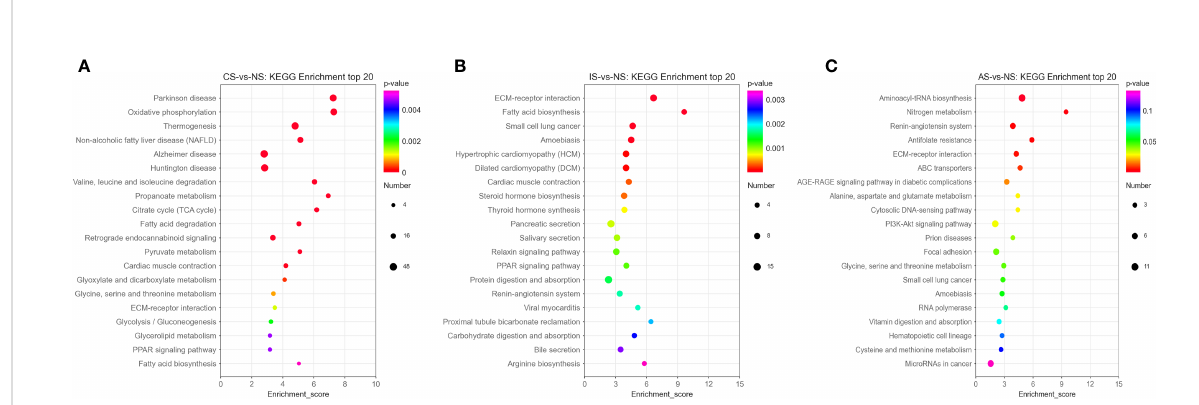
FIGURE 3 Pathway functional enrichment of differentially expressed genes (DEGs). (A) CS-vs-NS group. (B) IS-vs-NS group. (C) AS-vs-NS group. X axis represents enrichment score. Y axis represents pathway name. The color indicates the q value, the lower p-value indicates the more signi fi cant enrichment. Point size indicates DEG number (The larger dots refer to a larger